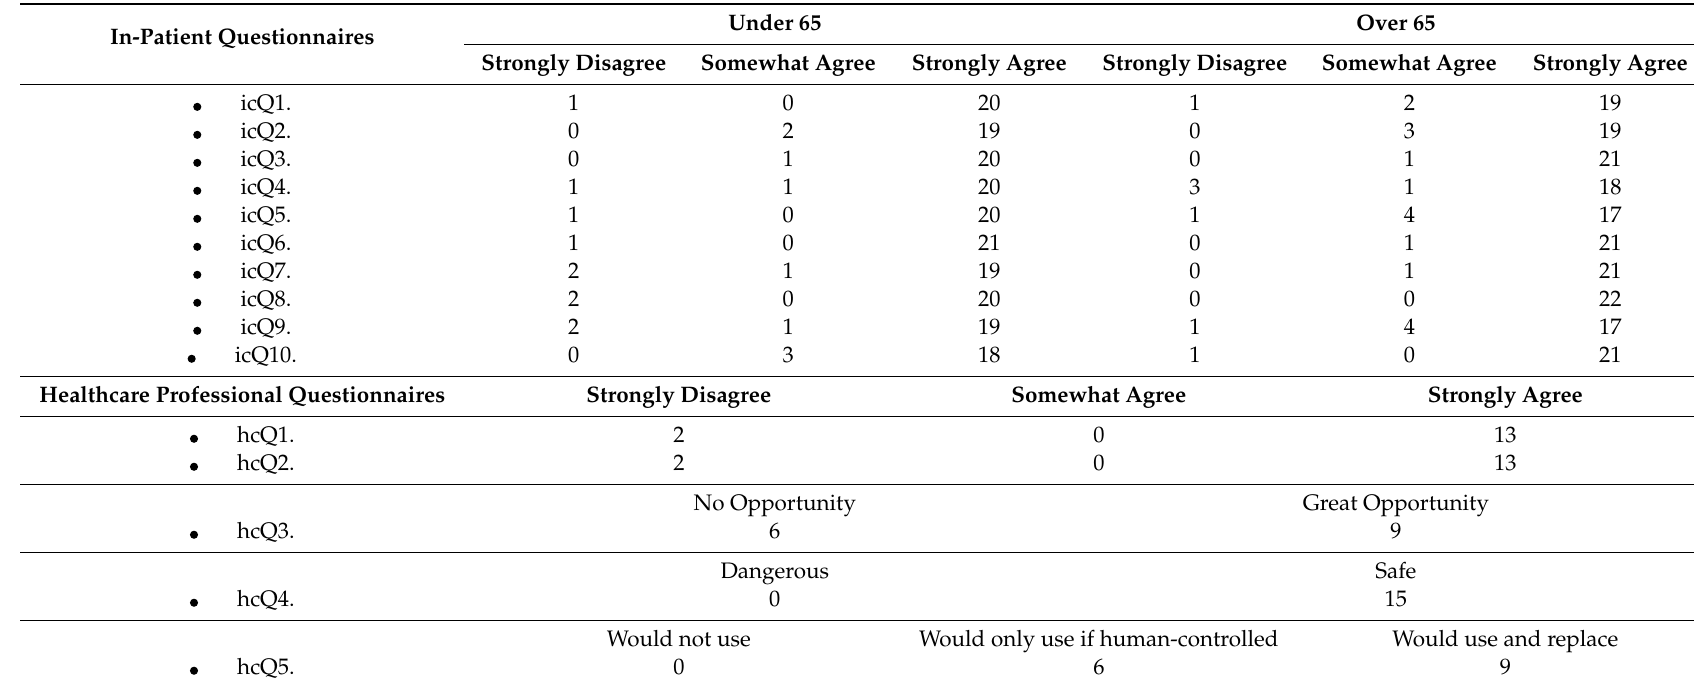
Table 2 describes (1) the frequency of responses for each descriptive category for in-patients ( n = 44); (2) the frequency of responses for each descriptive category for healthcare professionals ( n = 15). icQ1–10 and hcQ1–2 used a 1 to 7 rating scale: 1 to 2 (strongly disagree); 3 to 4 (somewhat agree); and 5 to 7 (strongly agree). hcQ3 used a 1 to 10 rating scale: 0 to 5 (no opportunity); and 6 to 10 (great opportunity). hcQ4 used a 1 to 10 rating scale: 0 to 5 (no danger); and 6 to 10 (danger). hcQ5 was collected with a − 3 to + 3 rating scale: − 3 (would not use the intervention); − 2 to 0 (would only use the intervention if controlled by a human caregiver); and 1 to 3 (would use the intervention and it could replace some interventions currently implemented by human